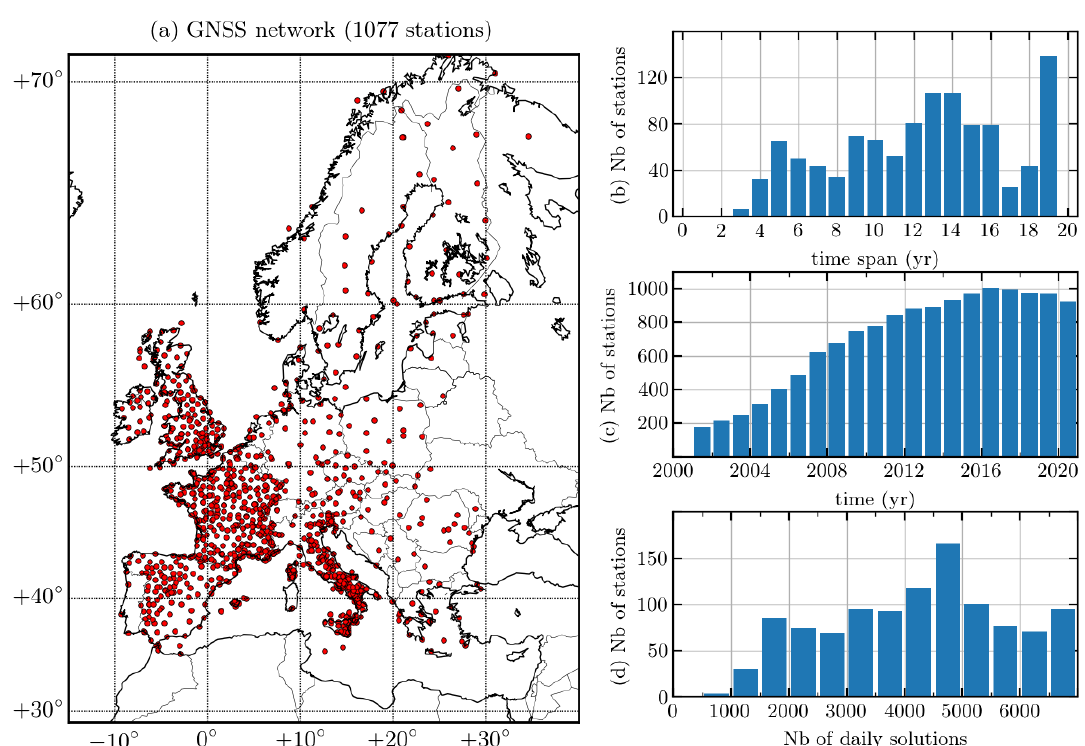
Figure 3. ( a ) GNSS station network and some characteristics in terms of ( b ) station time span, ( c ) station availability over time, and ( d ) daily solution in each